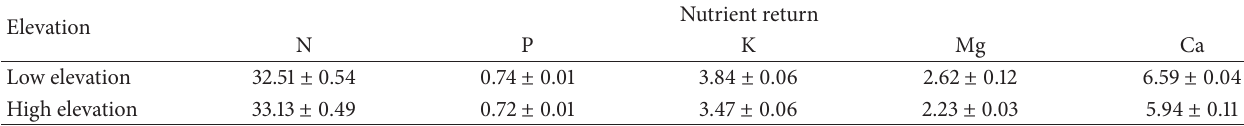
Nutrient return